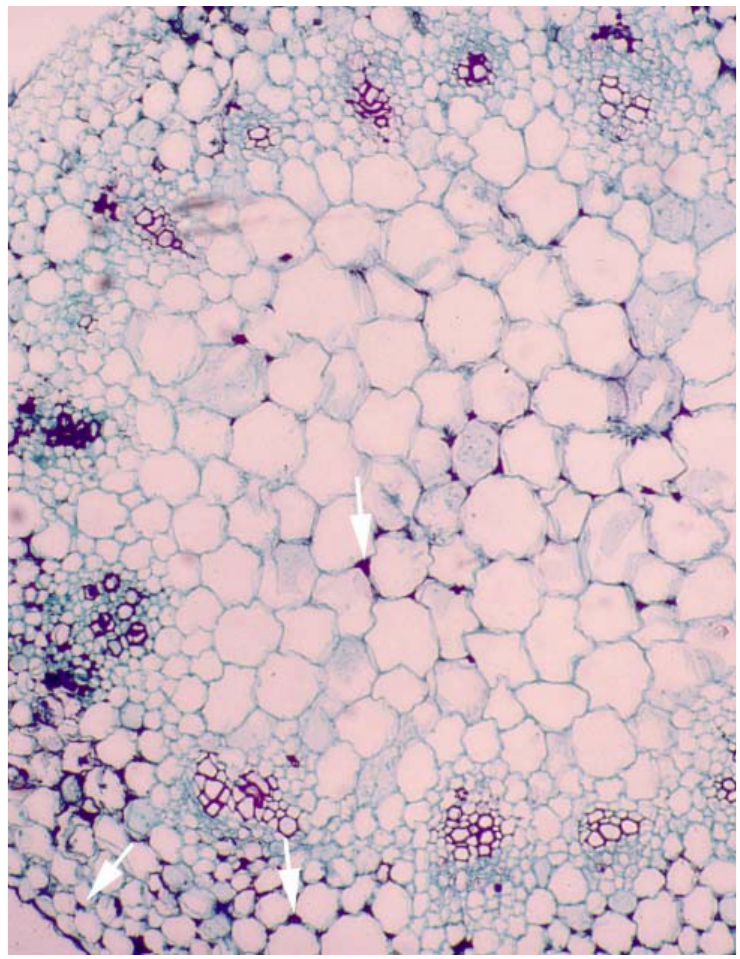
Fig. 3. Cross-section of an infected stem showing spread of the fungus through the intercellular spaces of the epider- mis, cortex, and pith (arrows). (cid:1)